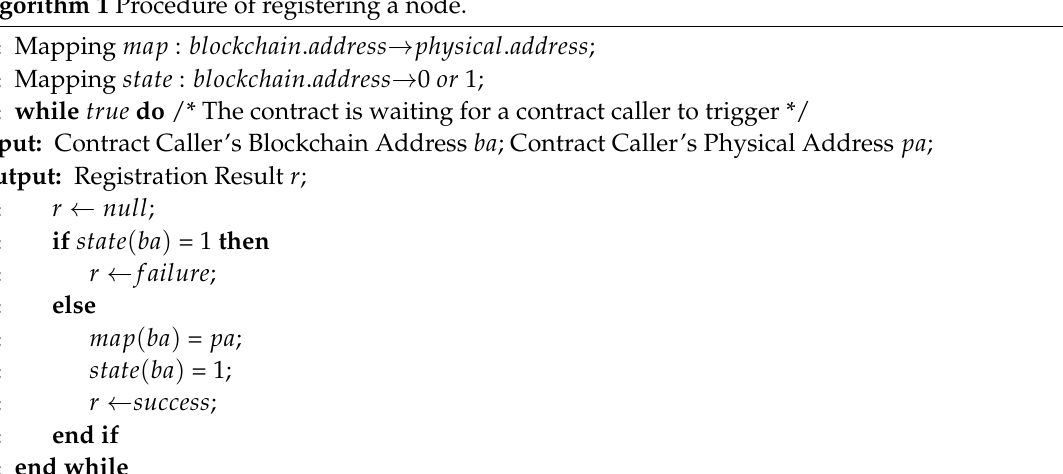
Figure 4. Specific formats of smart contracts and blockchain transactions. ( a ) Registration contract. ( b ) Token contract. ( c ) Token transaction. Algorithm 1 Procedure of registering a